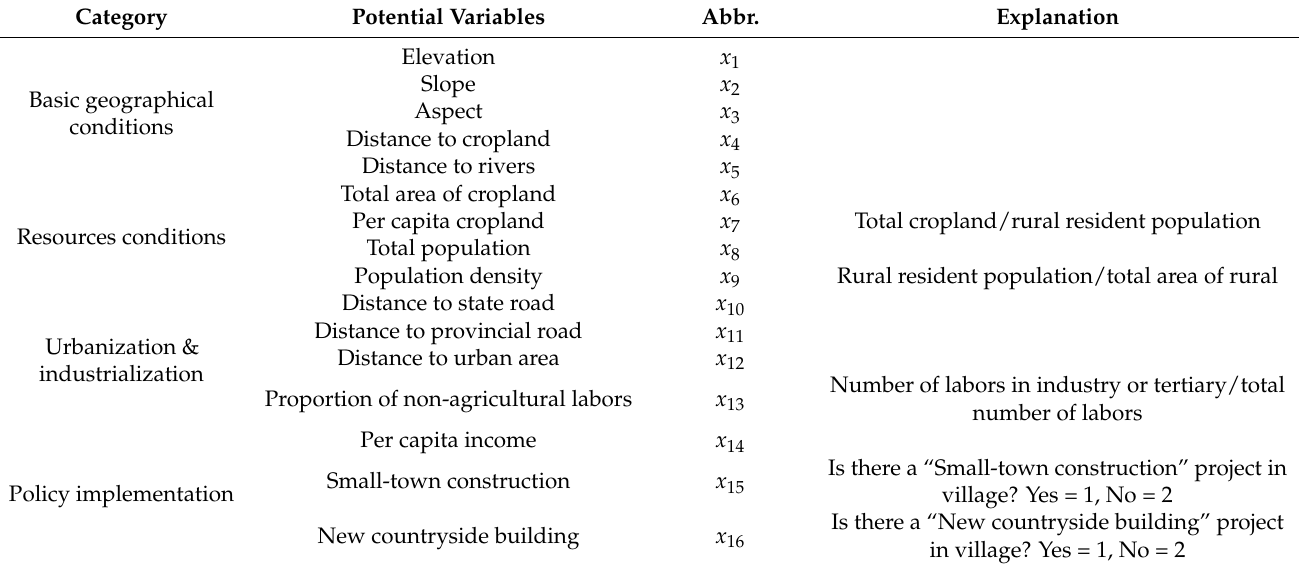
Table 1. Definitions of potential